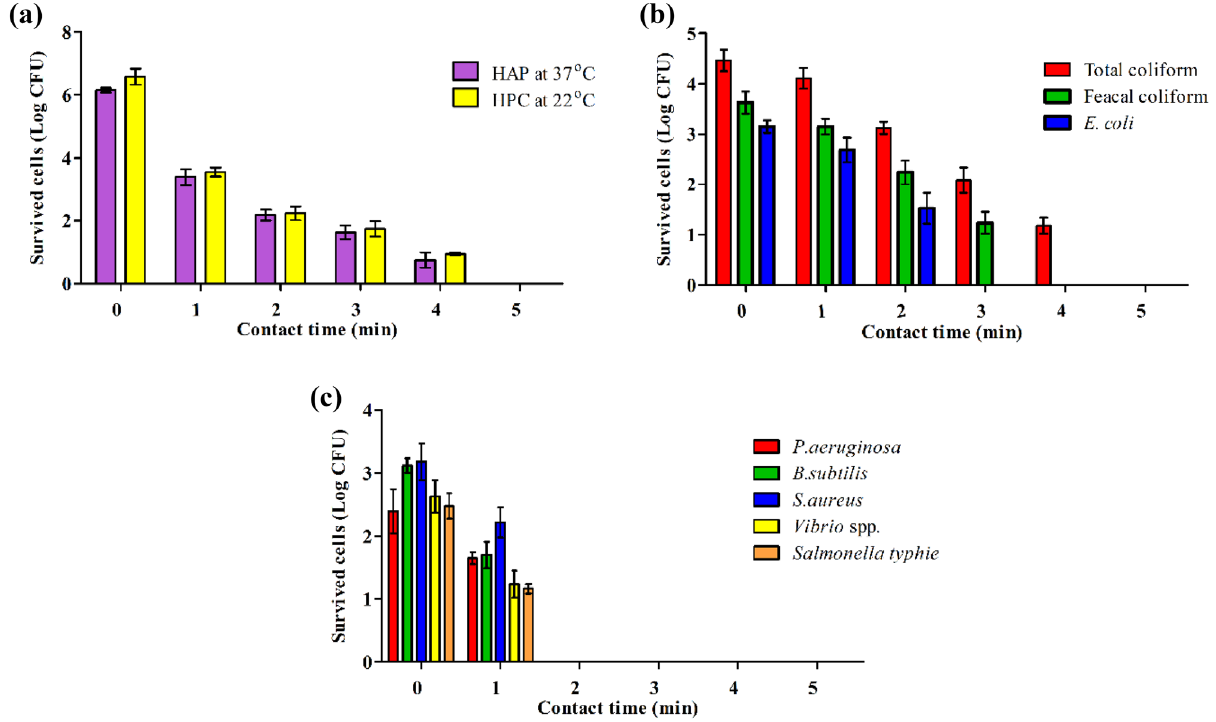
Figure 8. Efficacy of electrochemical disinfection, as a function of time, of some waterborne bacterial species ( a ) HPC at 37 °C and 22 °C, ( b ) fecal bacterial indicator, ( c ) some potential pathogenic bacteria for drainage wastewater under stable